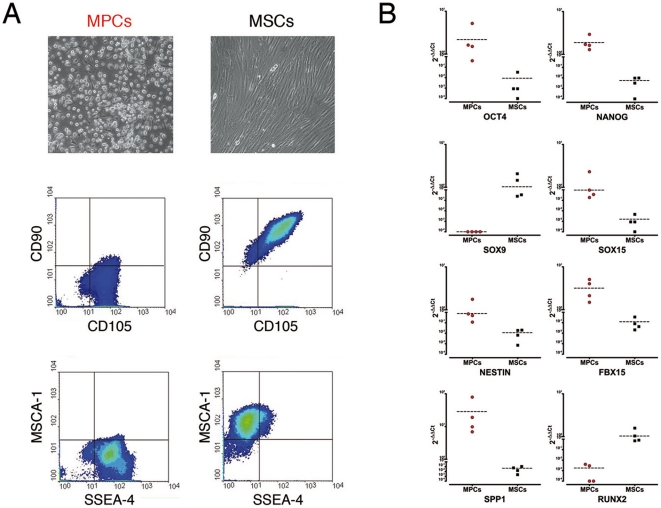
Characterization of MPC and MSC primary cultures.Culturing BMMNCs in PhABS or FBS resulted in two highly monomorphic cultures of MPCs and MSCs, respectively. (A) MPCs were rounded and highly rifrangent (Leica DM-IRB 100X, phase contrast) expressing SSEA-4, low levels of CD105, and no CD90 and MSCA-1 MSC markers. Cytofluorimetric analysis showed high purity for both cultures. (B) Gene expression profiling confirmed the peculiar molecular signature of MCPs (red dots) characterized by the expression of pluripotency-associated genes. MSC (black squares) profile was significantly different from that of MPC (p<0.01), with the high expression of RUNX2 and SOX9.